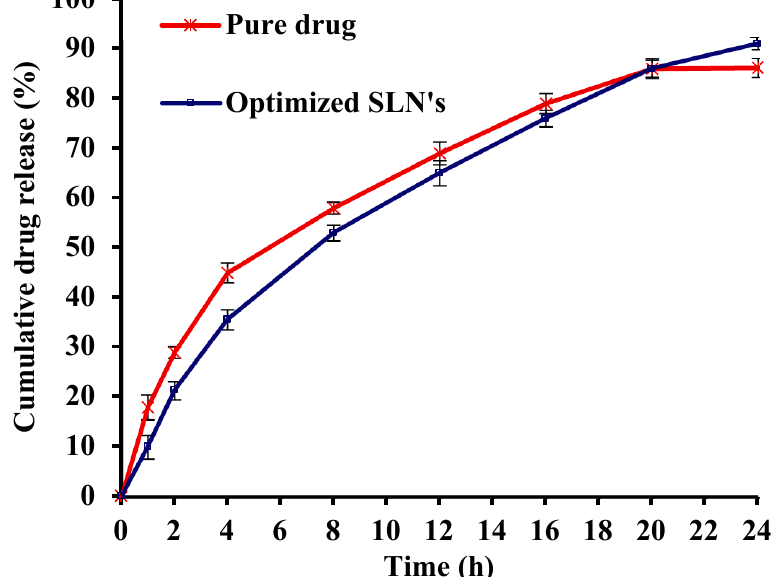
Figure 2. In vitro diffusion study release profiles of pure drug and optimized Saxagliptin SLNs.